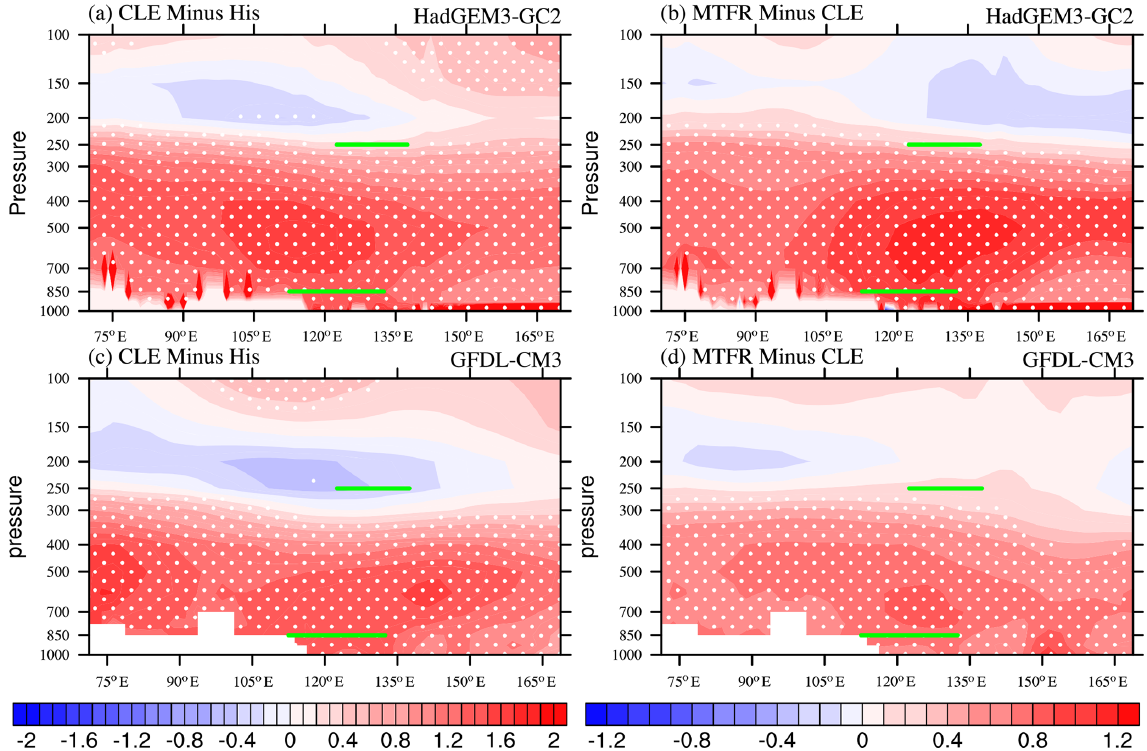
Figure 5. The difference in winter mean temperature (K) along 40 ◦ N (a, c) between CLE (2015–2049) and His (1984–2013) and (b, d) between MTFR (2015–2049) and CLE (2015–2049). The dotted areas are statistically significant at the 10% level using a Student’s t test. The green lines indicate the level and longitude used in the calculation of (cid:49)T